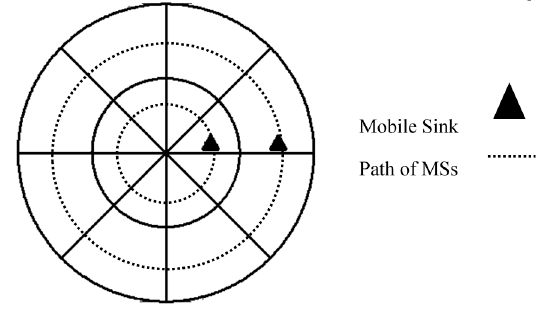
Figure 3. Circular motion of MSs in CCWSN .